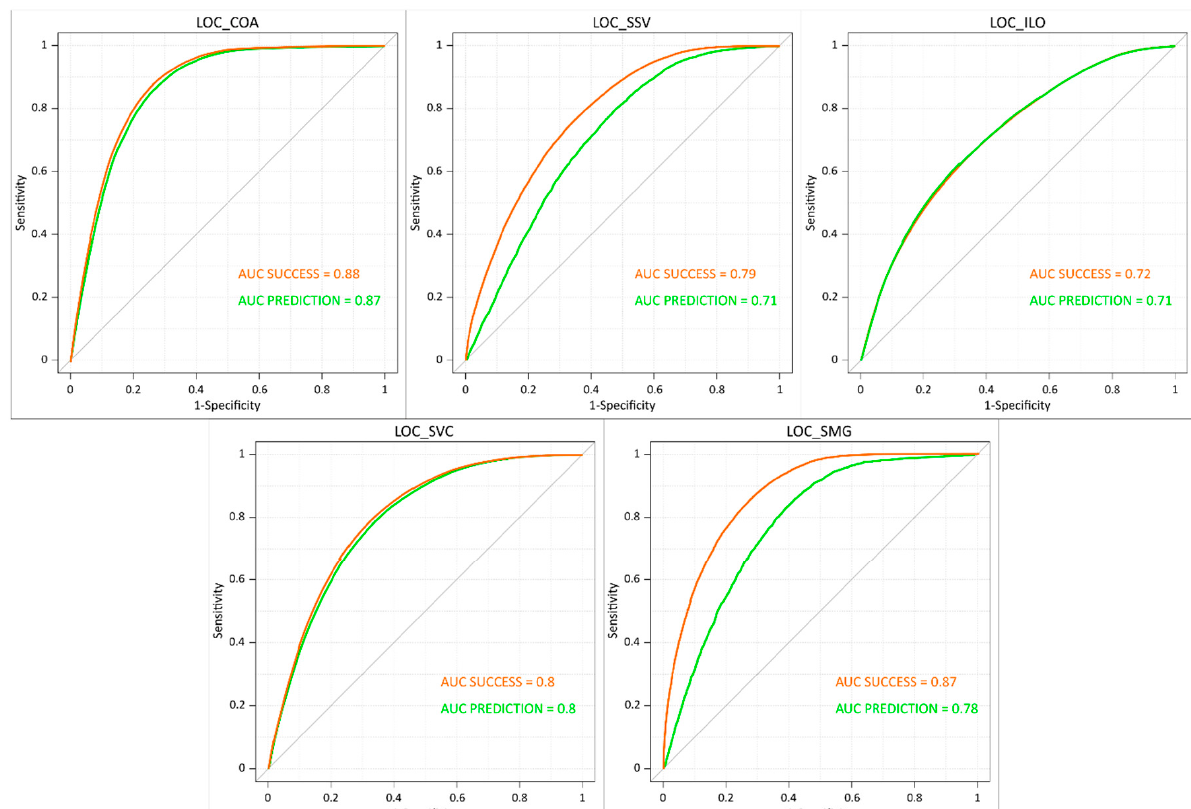
Figure 3. ROC plots and relative AUC values for the LOC models.